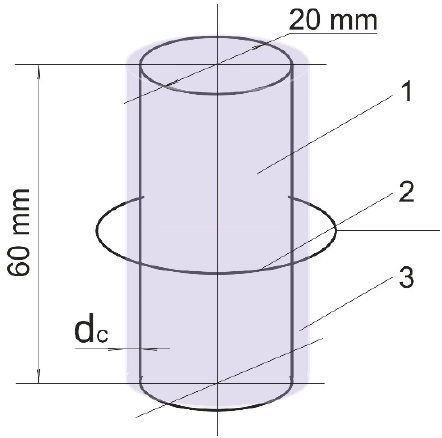
Figure 7. The schematic view of experiments: 1- treated samples (cathode); 2- anode ring; 3- plasma of glow discharge; d c - the length of the cathode potential drop.